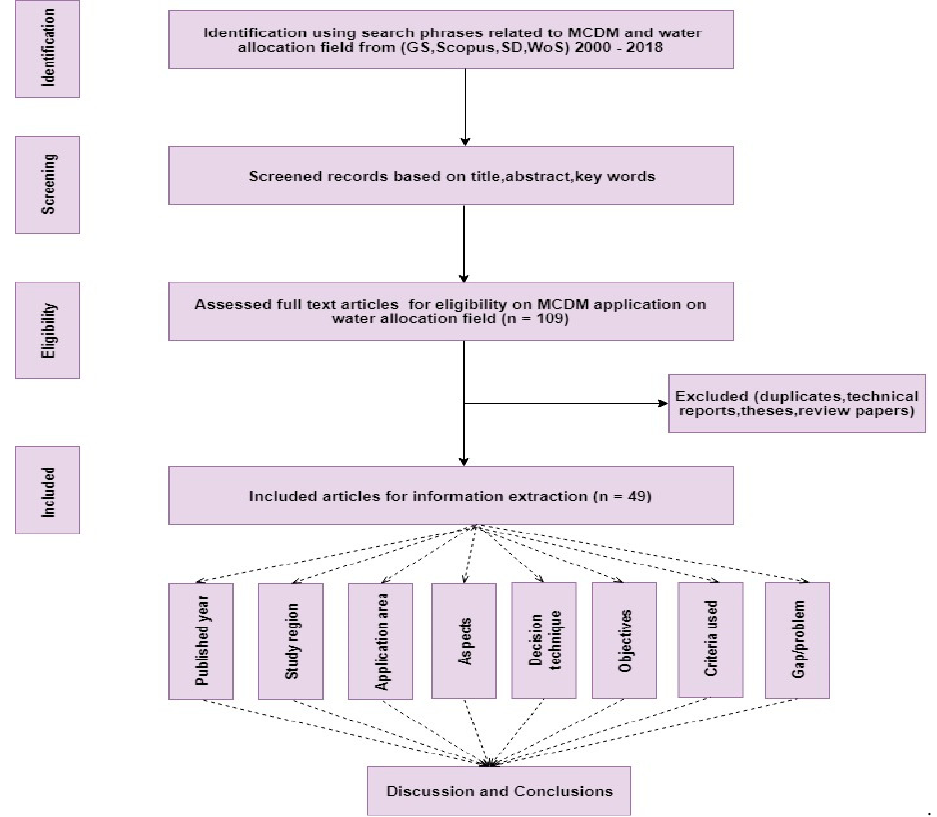
Figure 2. Study flow chart of identification, screening, eligibility, and included articles.